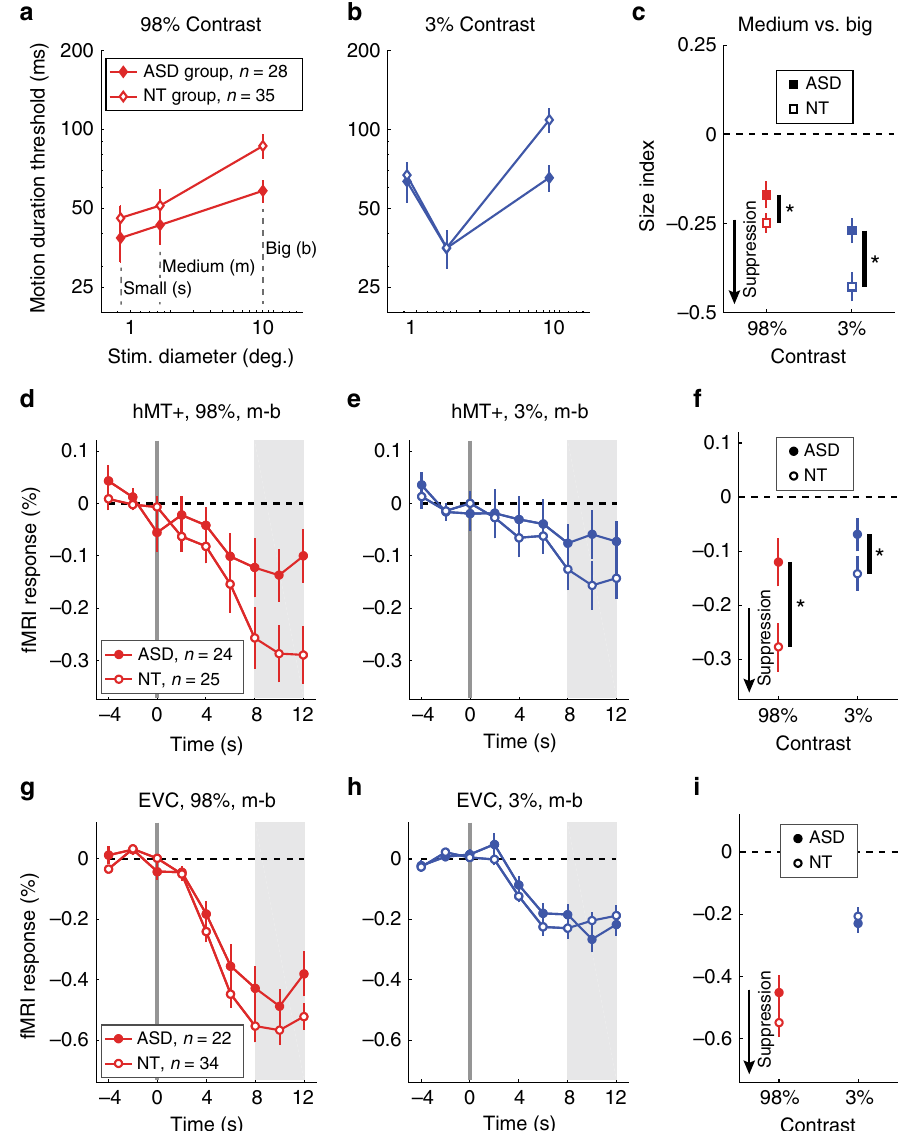
Fig. 2 Behavioral and fMRI results. a Motion duration thresholds for high-contrast (98%) drifting gratings. The time required to perceive whether stimuli drifted left or right with 80% accuracy is shown on the y -axis for different stimulus sizes ( x -axis). b The same, but for low-contrast gratings (3%). c The effect of increasing stimulus size on duration thresholds was quanti fi ed using a size index — the difference between log thresholds (Eq. 3). More negative values indicate stronger suppression (black arrow). Participants with ASD show weaker spatial suppression during motion discrimination than NTs (asterisk: ANOVA, main effect of group, p = 0.003). d fMRI responses in foveal human MT complex (hMT + ) to an increase in stimulus size; at time = 0 s, high-contrast drifting gratings increased in size from medium (m) to big (b). e The same, but for low-contrast gratings. f Average fMRI responses for each group (from shaded regions in e , f ). Suppression of the fMRI response in hMT + is weaker among participants with ASD (asterisk: ANOVA, main effect of group, p = 0.022). g – i are the same as d – f but for a foveal region of early visual cortex (EVC). Samples sizes for each row are shown in a , d , and g . Dots show group means; error bars are